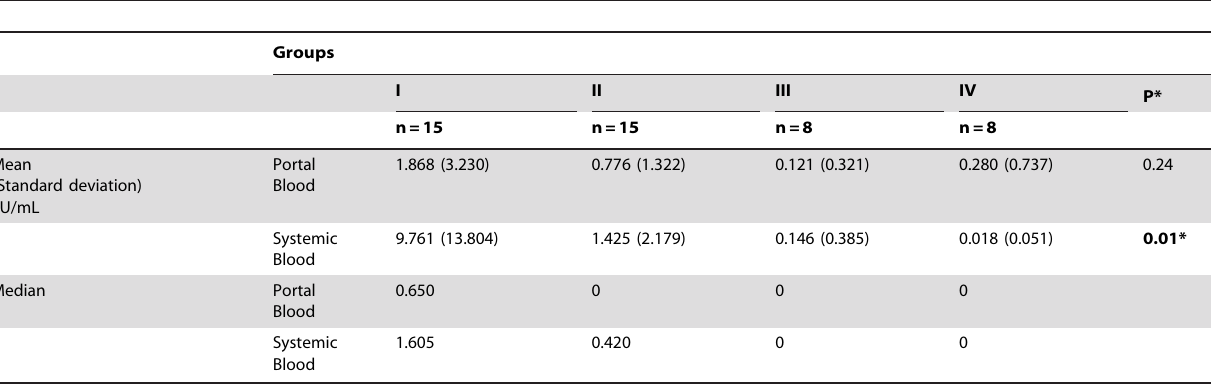
Table 5. Concentration of endotoxin in the portal and systemic blood of rats submitted to surgical procedures or